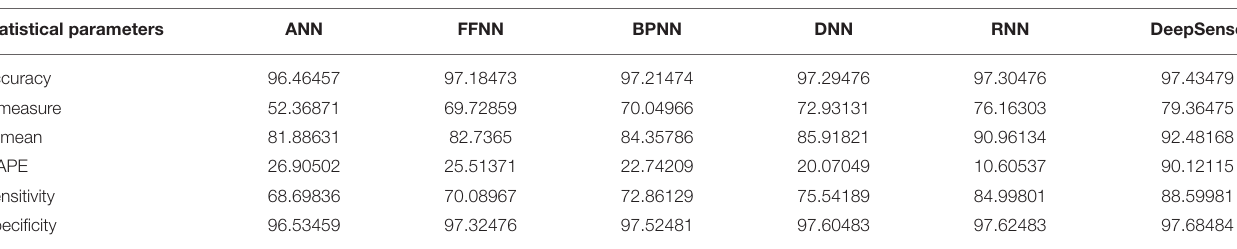
TABLE 4 | Results of statistical parameters for IEEE8023 with 80% training data on 1,000